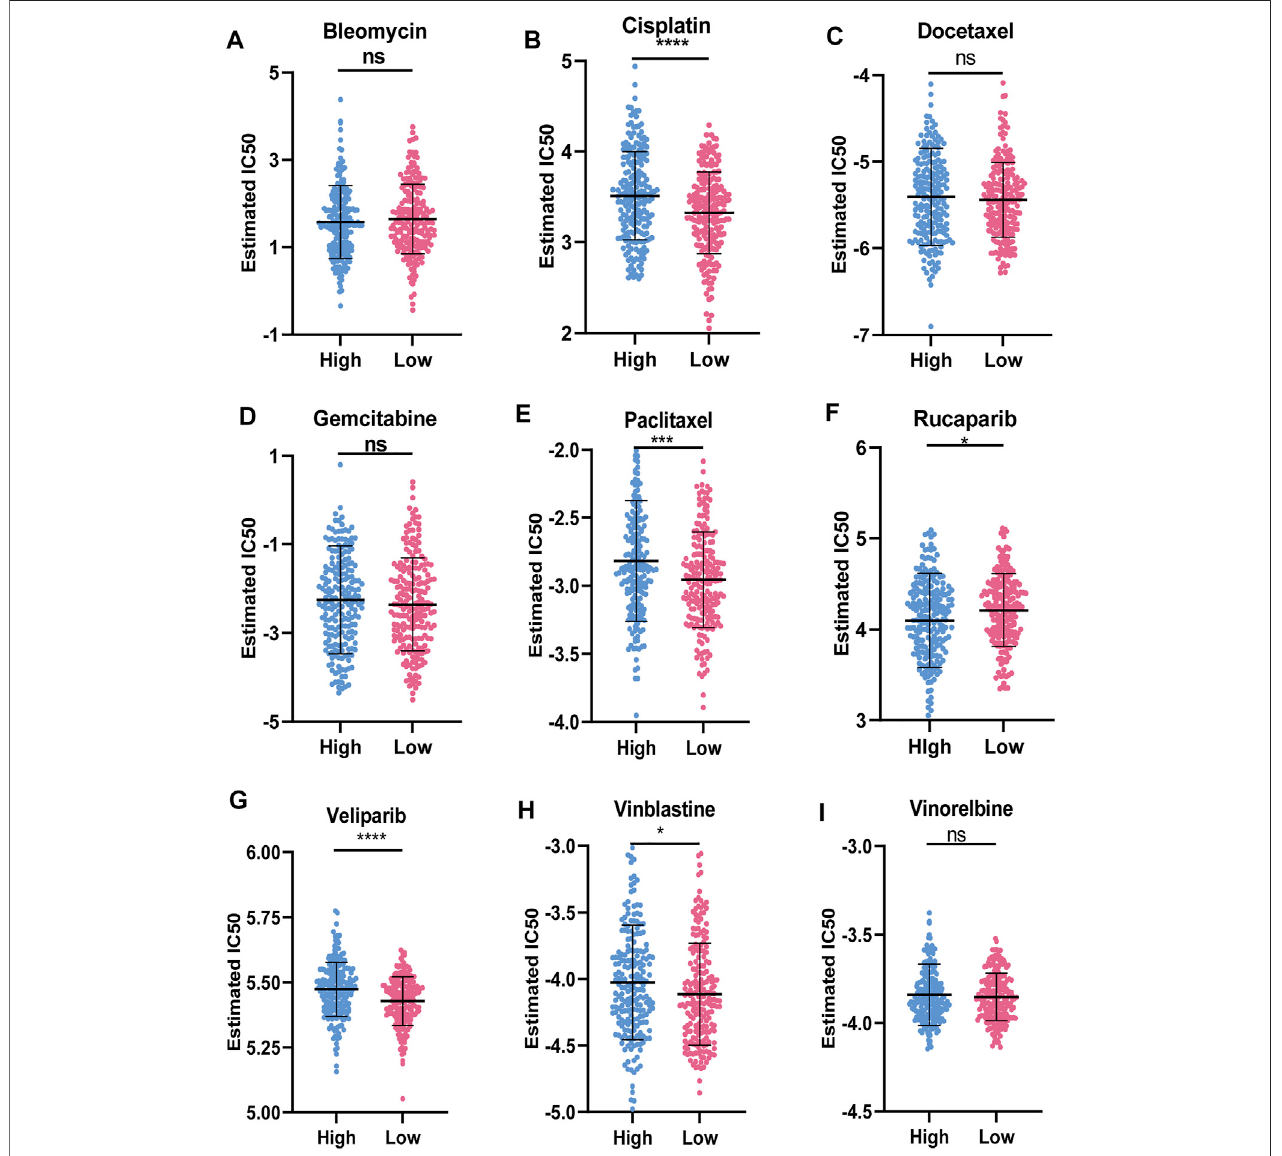
FIGURE 8 | Sensitivity of chemotherapy drugs (A-I) Difference in the estimated IC50 levels of Bleomycin (A) , Cisplatin (B) , Docetaxel (C) , Gemcitabine (D) , Paclitaxel (E) , Rucaparib (F) , Veliparib (G) , Vinblastine (H) , and Vinorelbine (I) . Data are shown as means ± S.D. ns: not signi fi cant, * p < 0.05, ** p < 0.01, *** p < 0.001, **** p <